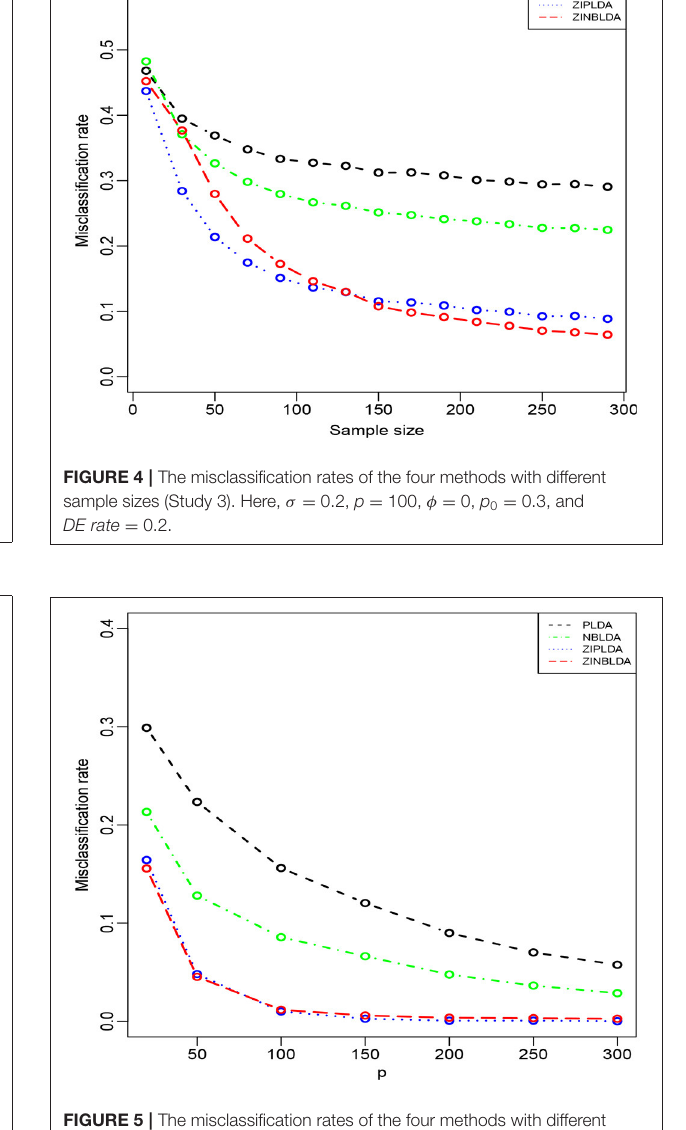
FIGURE 3 | The misclassification rates of the four methods with different probabilities of excess zeros (Study 2). Here, σ = 0.2, p = 100, n = 50, φ = 0, and DE rate = 0.2.